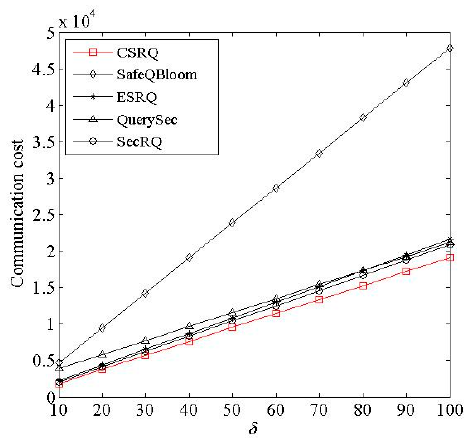
Figure 7. Impacted of δ on communication cost.